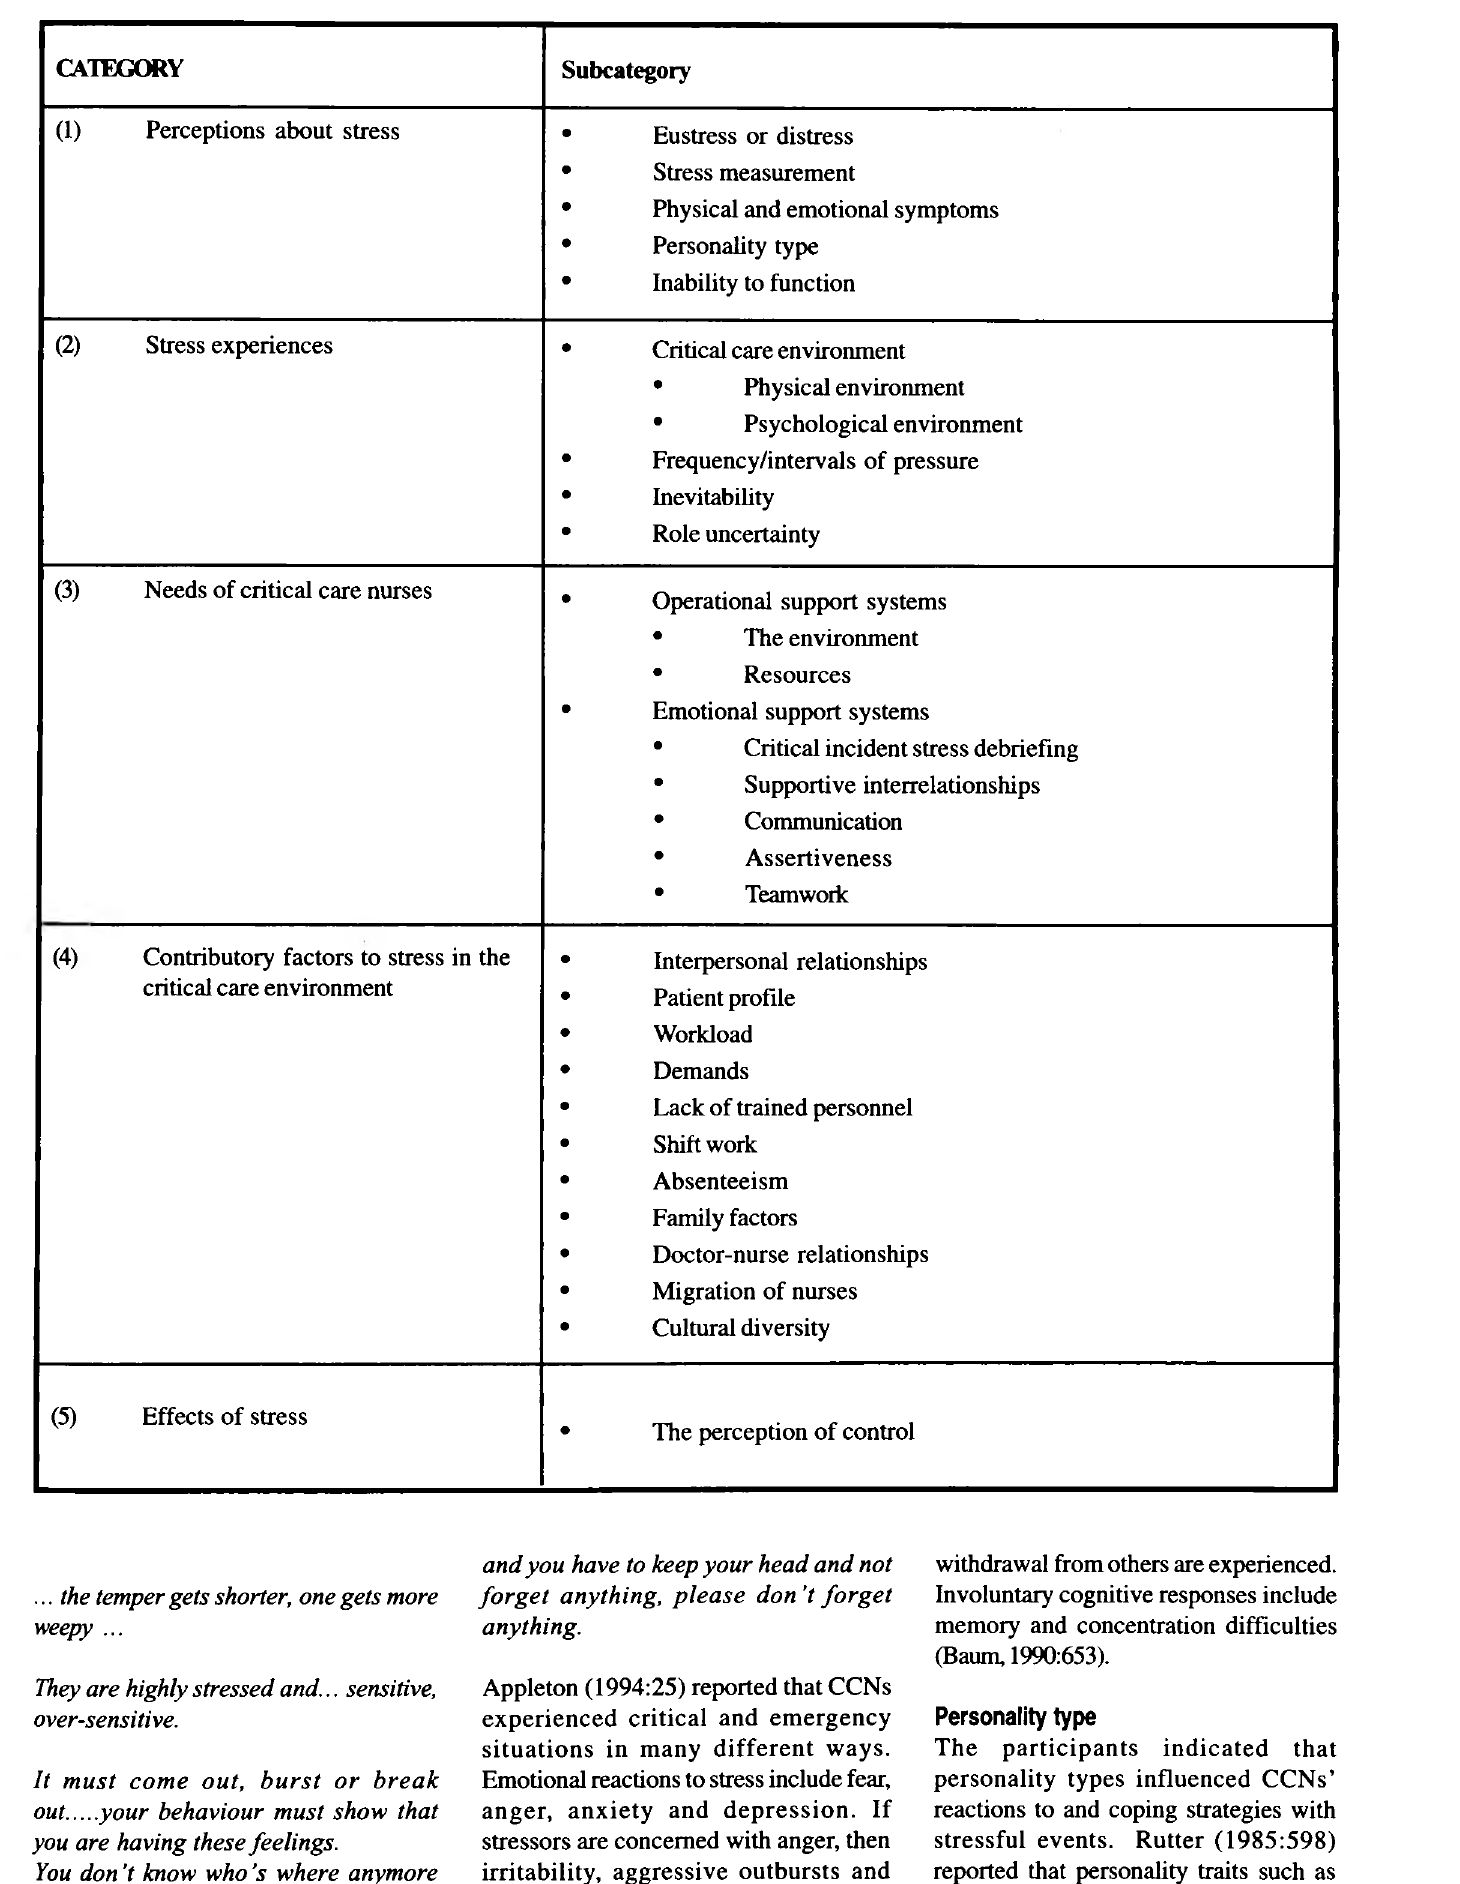
Table 2: Summary of major categories, subcategories and sub-sub categories